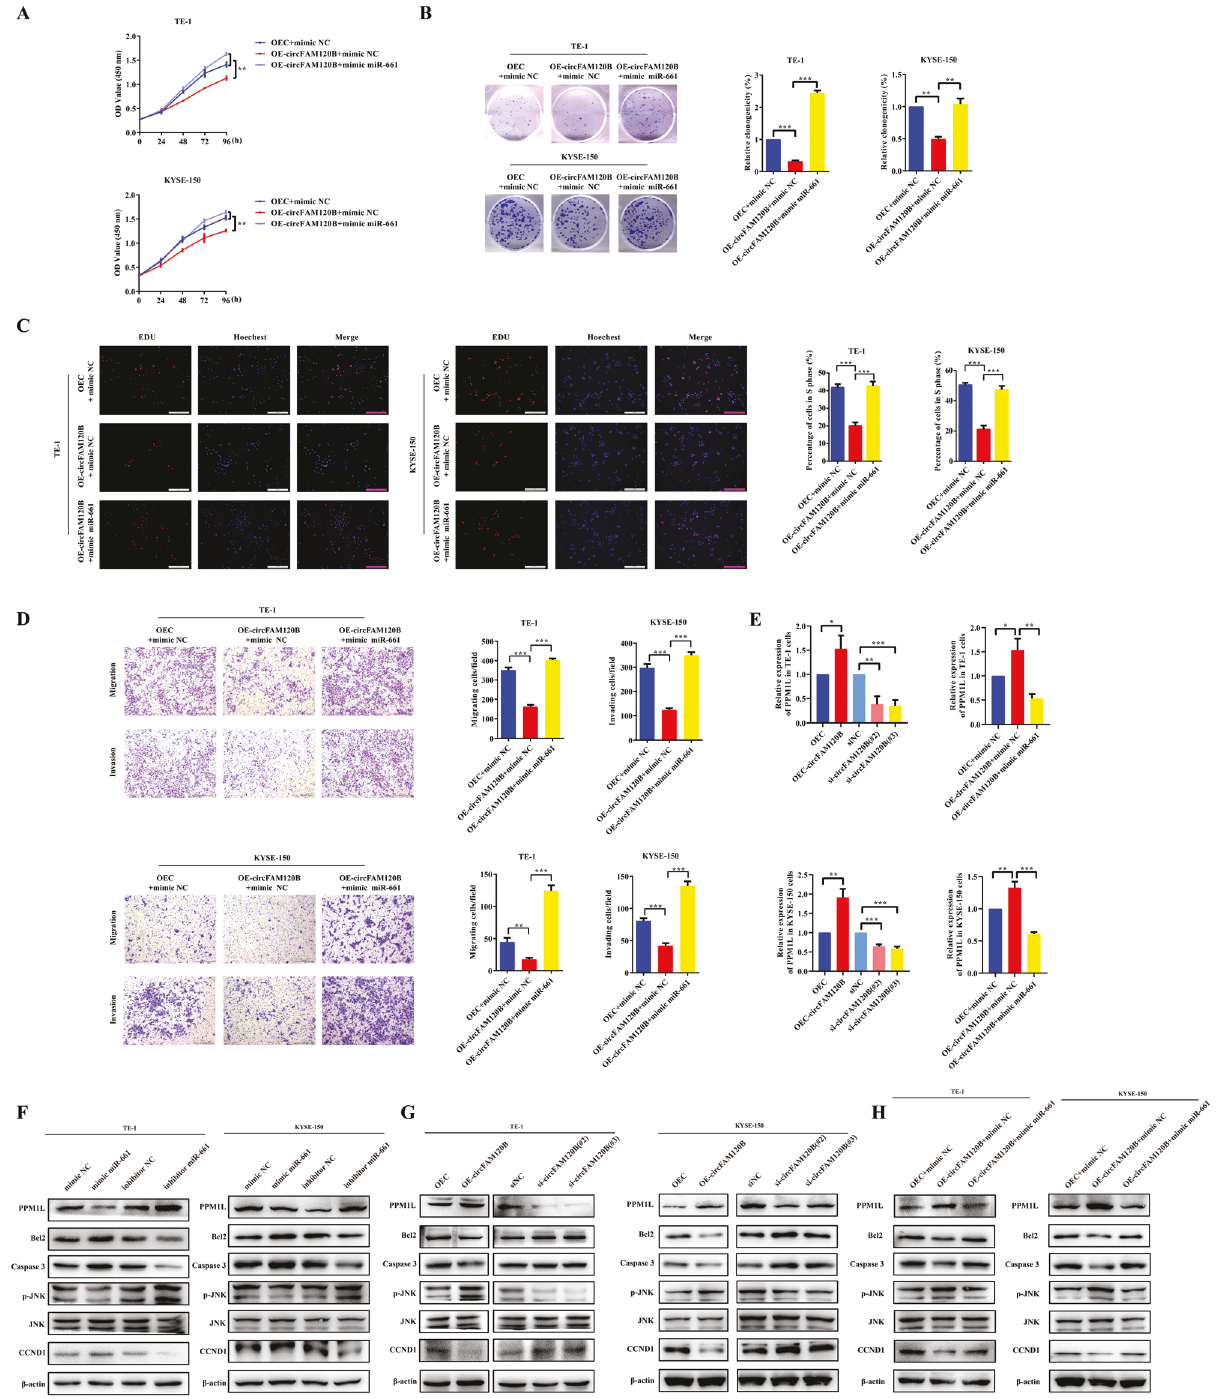
Fig. 4 circFAM120B inhibits the tumorigenicity of ESCC by binding with miR-661 to restore PPM1L expression. A Proliferation of ESCC cells co-transfected as indicated was assessed by CCK-8 assay ( n = 5 biologically independent replicates). B Colony formation assays were performed in ESCC cells co-transfected as indicated ( n = 3 biologically independent replicates). C Detection of the proliferating ESCC cells with circFAM120B overexpression or knockdown by EdU assay ( n = 3 biologically independent replicates). D Migration and invasion of ESCC cells co-transfected as indicated were examined by Transwell assays ( n = 3 biologically independent replicates). E Expression of PPM1L was examined by qRT-PCR in ESCC cells transfected as indicated. F – H The expression levels of speci fi c proteins were analyzed by western blot analysis in ESCC cells treated as indicated. * P < 0.05, ** P < 0.01, *** P <